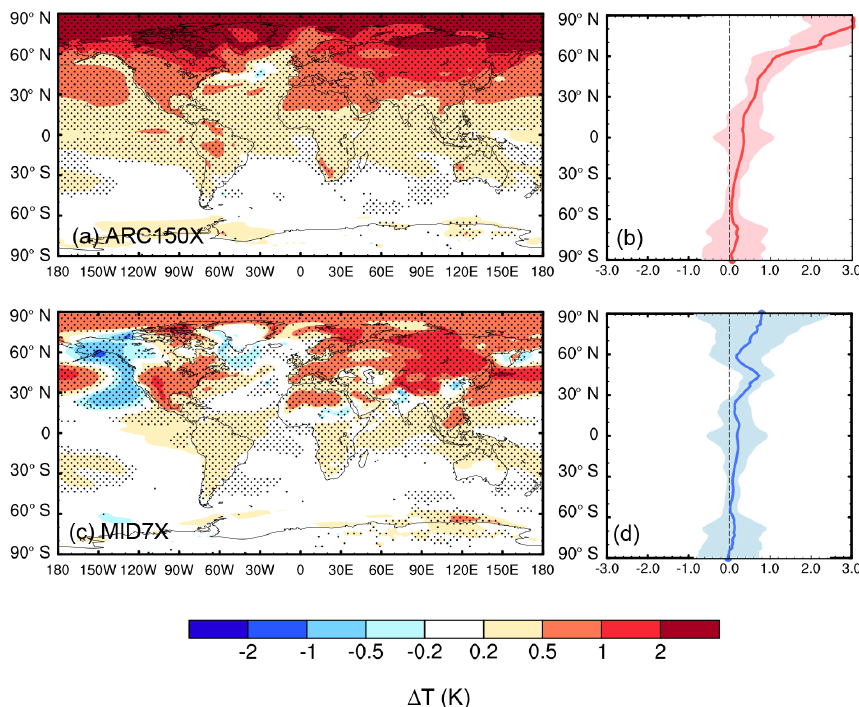
Figure 2. Spatial distribution (a, c) and zonal mean (b, d) of changes in annual mean surface air temperature (K) for ARC150X (a, b) and MID7X (c, d) compared to PD. The dotted areas in (a, c) indicate statistical significance with 95% confidence from a two-tailed Student’s t test.